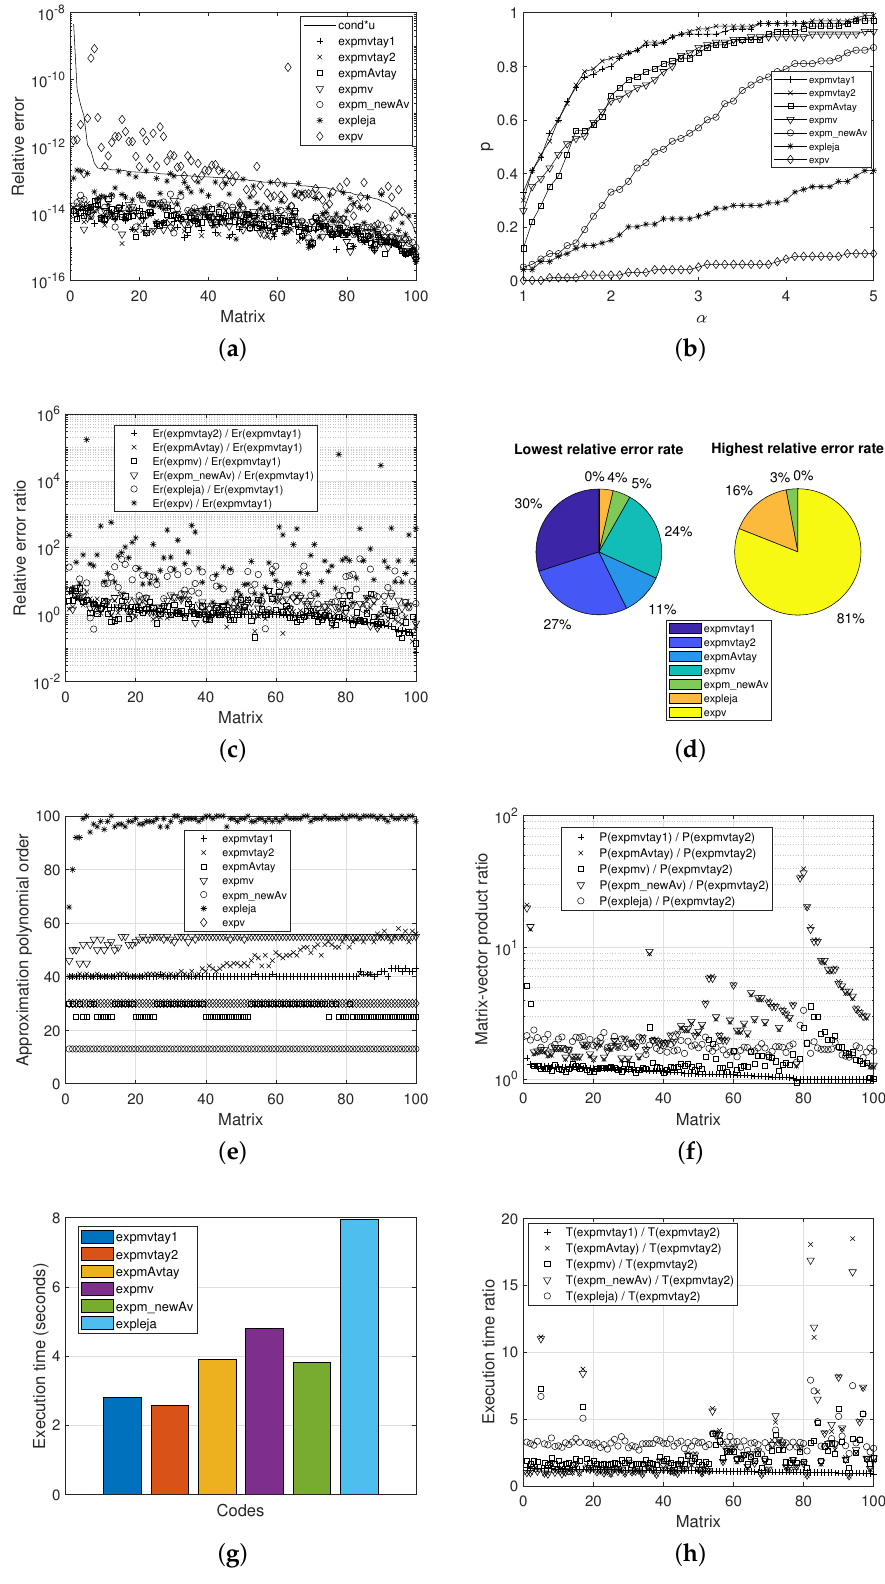
Figure 2. Experimental results for Set 2. ( a ) Normwise relative errors. ( b ) Performance profile. ( c ) Ratio of relative errors. ( d ) Lowest and highest relative error rate. ( e ) Polynomial, interpolation and subspace orders. ( f ) Ratio of matrix–vector products. ( g ) Execution time. ( h ) Ratio of execution